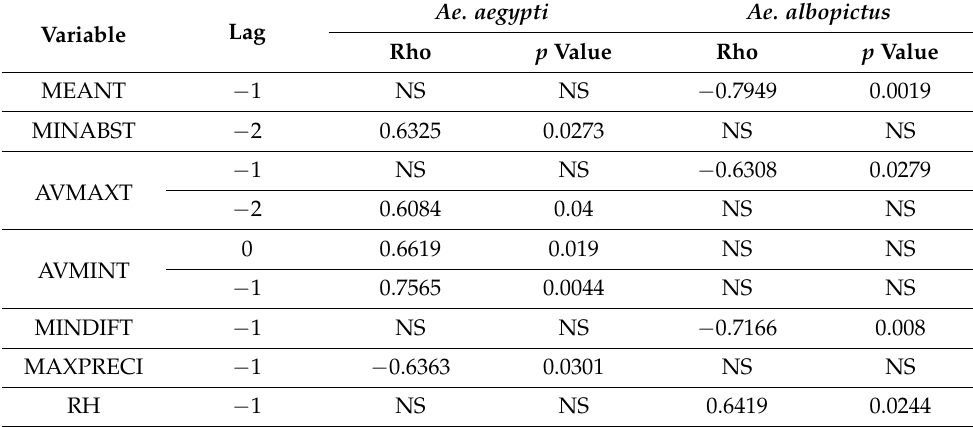
Table 7. Correlations at 95% confidence between vector IRs and climate